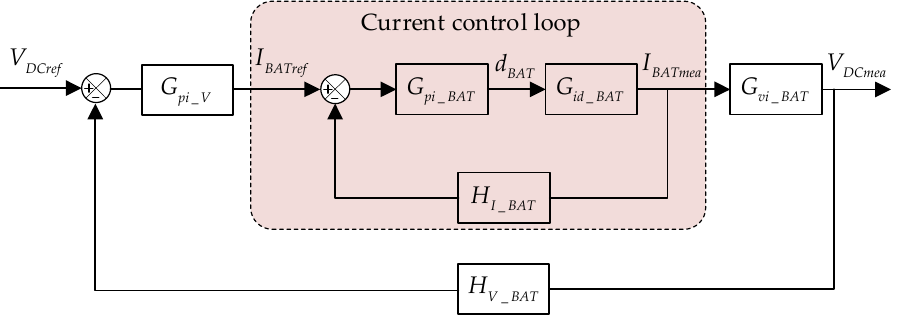
Figure 12. Block diagram of the controllers for BAT converter.